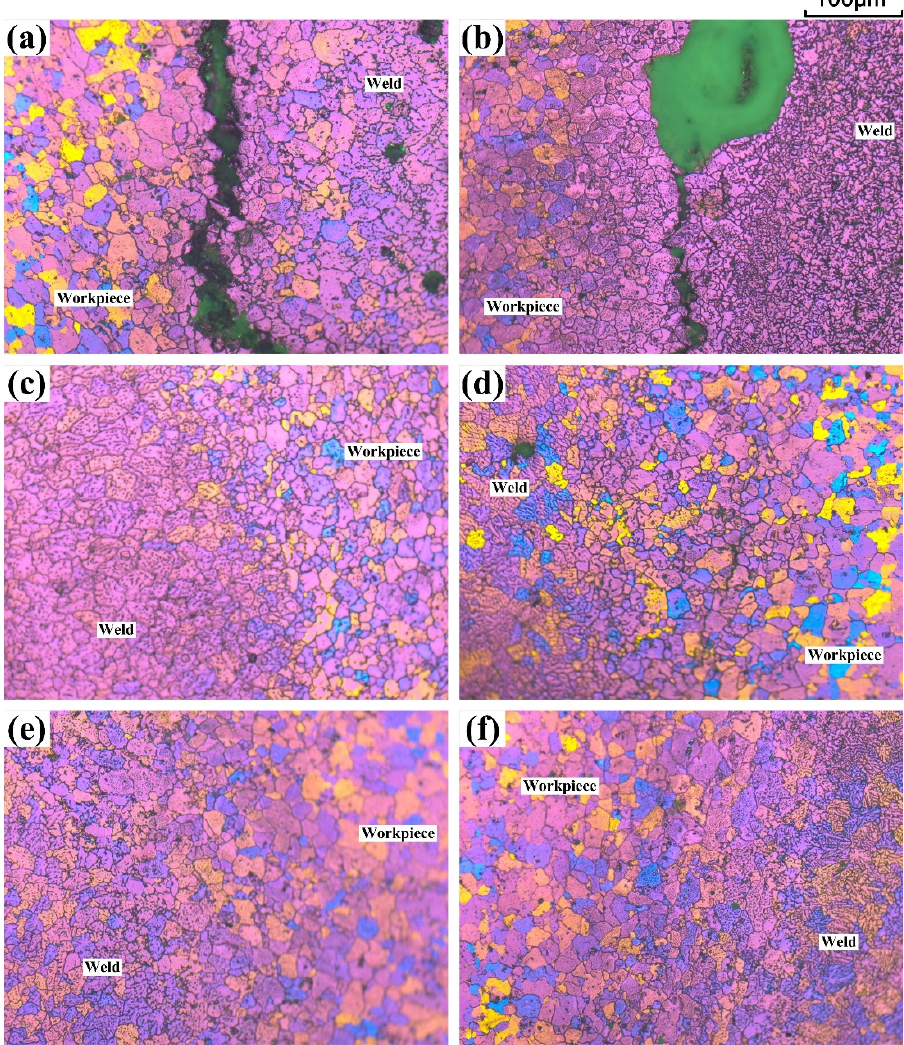
Figure 6. Color metallography images of different joints (circular-patch welding): ( a ) The AA7075/ER5356 joint; ( b ) AA7075/Al-Cu 1.5 -Si 4.5 joint; ( c ) the AA7075/Al-Cu 3.0 -Si 2.5 joint; ( d ) the AA7075/Al-Cu 4.5 -Si 1.5 joint; ( e ) the AA7075/Al-Cu 2.3 -Mg 2.3 -Zn 6.6 joint; ( f ) the AA7075/Al-Cu 2.2 -Mg 2.0 -Zn 7.8 joint.